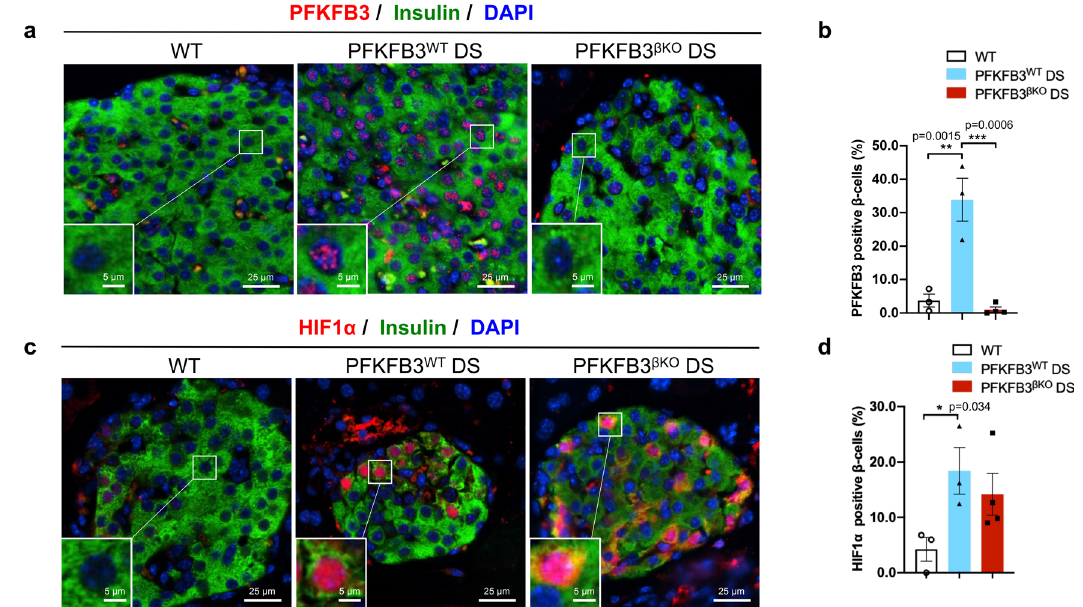
Fig. 1 HIF1 α is upregulated in PFKFB3 β KO DS mice under high diabetogenic stress. a Representative immuno fl uorescence images of islets from WT, PFKFB3 WT DS, and PFKFB3 β KO DS mice at 13 weeks HFD immunostained for PFKFB3 (red), insulin (green) and nuclei (blue). b Quanti fi cation of images in ( a ) (** p = 0.0015, *** p = 0.0006). c Representative immuno fl uorescence images of islets from WT, PFKFB3 WT DS and PFKFB3 β KO DS mice at 13 weeks HFD immunostained for HIF1 α (red), insulin (green) and nuclei (blue). d Quanti fi cation of images in ( c ) ( n = 3, n = 4 for PFKFB3 β KO DS – independent animals, SEM * p = 0.034).